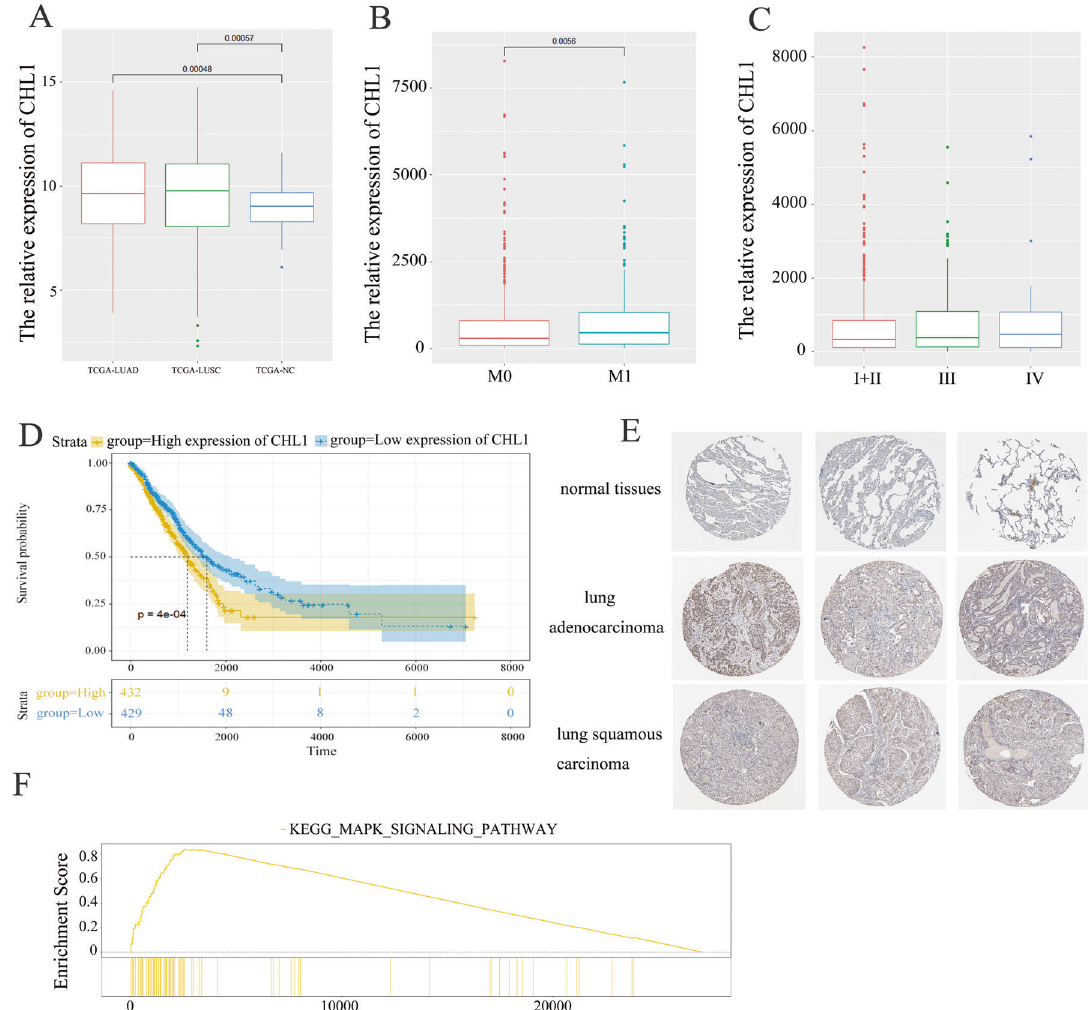
Fig. 1 CHL1 is signi fi cantly upregulated in NSCLC. A The expression level of CHL1 in the TCGA-NSCLC cohort. B The expression level of CHL1 in patients with M0 and M1. C The expression level of CHL1 in patients with I + II, III, and IV. D The survival analysis of CHL1 in the TCGA-NSCLC cohort. E The immunohistochemical results of CHL1 in normal tissue, adenocarcinoma, and squamous cell carcinoma from THPA. F The GSEA result of CHL1 in the TCGA-NSCLC